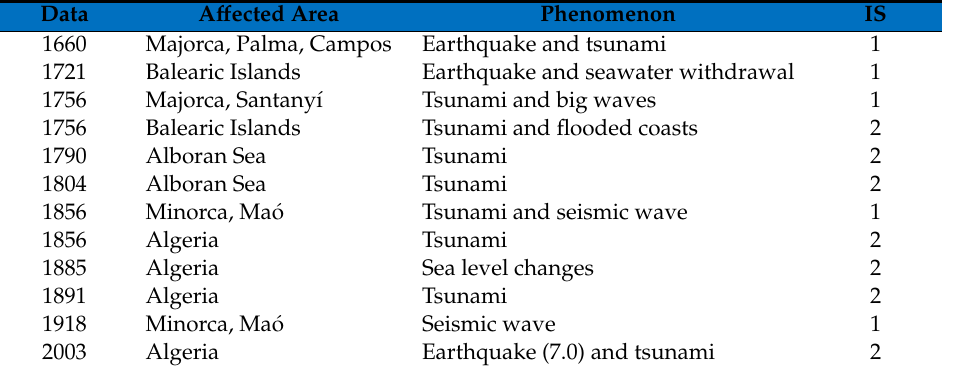
Figure 3. Modeling estimated travel time and impact areas based on the tsunami records of 21 May, 2003 [34]. Blue dots record background seismicity from 1998–2005 (CSEM-EMSC). Green rectangles record tide gauges with precise sampling rates. Table 2. Historical tsunamis phenomena were impacting in the Balearic Islands, modified from [36]. Information sources (IS): (1) [35] and (2) [37,38].